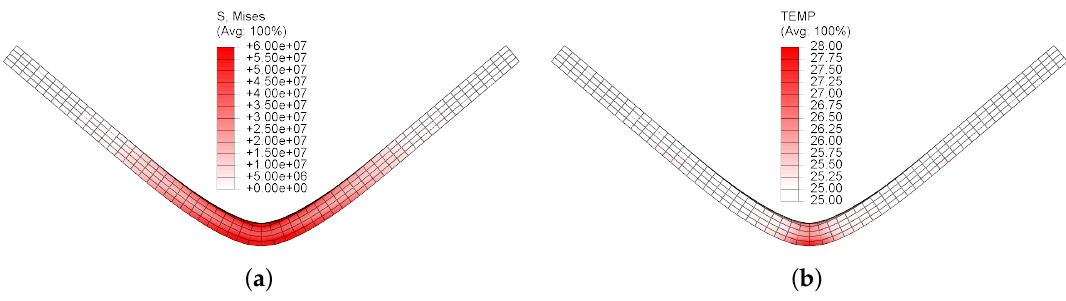
Figure 5. von Mises stress ( a ) and temperature ( b ) contour plots when the polycarbonate beam undergoes large deformation and